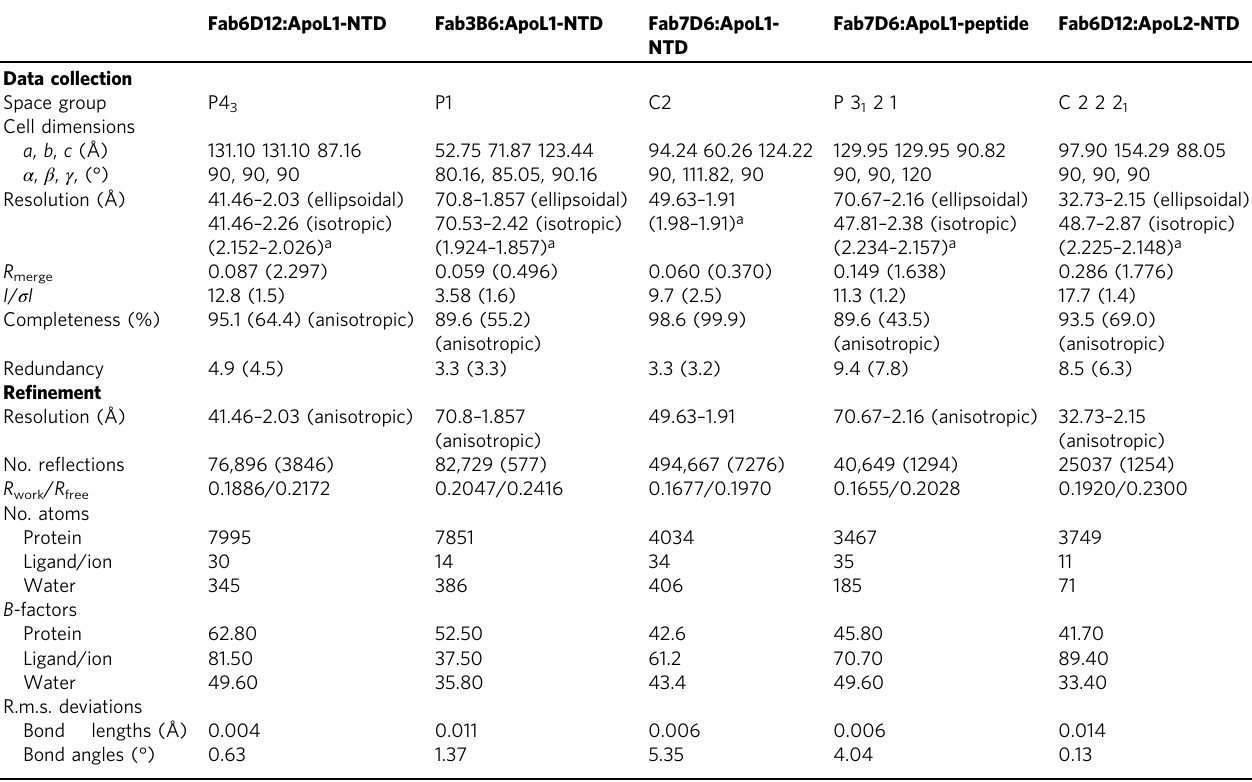
Table 1 Data collection and re fi nement statistics of crystal